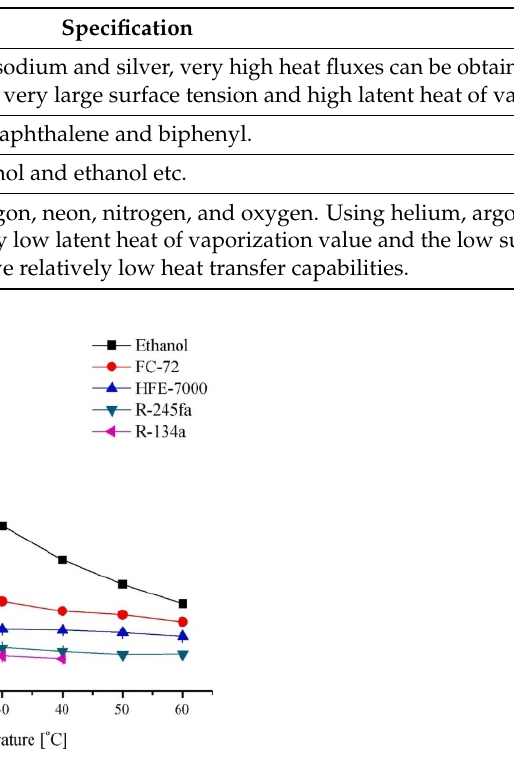
Table 3 . Working fluids at different working temperatures [29–31]. Table 3. Working fluids at different working temperatures [29–31].